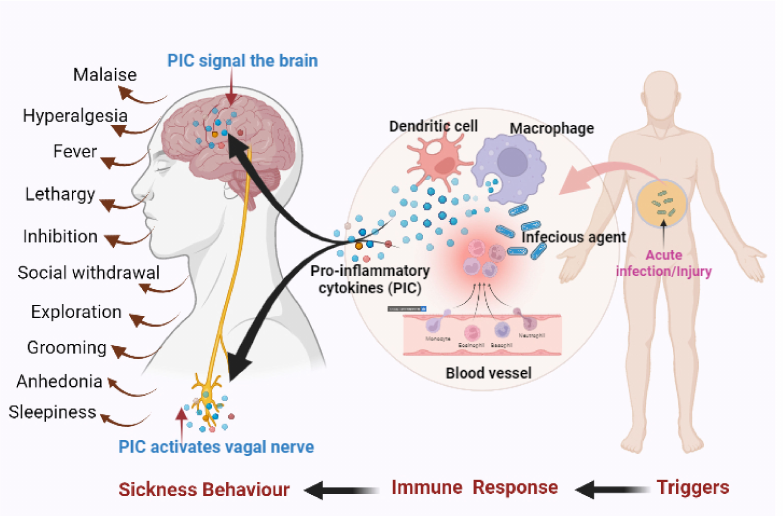
Figure 1. Role of the host immune system and proinflammatory cytokines in sickness behaviour. Acute infection or tissue injury acts as a trigger for the innate immune system. Dendritic cells and macrophages accumulate at the site of the infection or injury. The activated dendritic cells and macrophages release proinflammatory cytokines (PICs). The peripheral cytokines activate the vagal nerve, and some of the cytokines cross the blood–brain barrier and activate additional cytokine release from the brain. The brain is signalled by the released cytokines to start a series of behaviours (i.e., sickness behaviours). Figure created with the help of